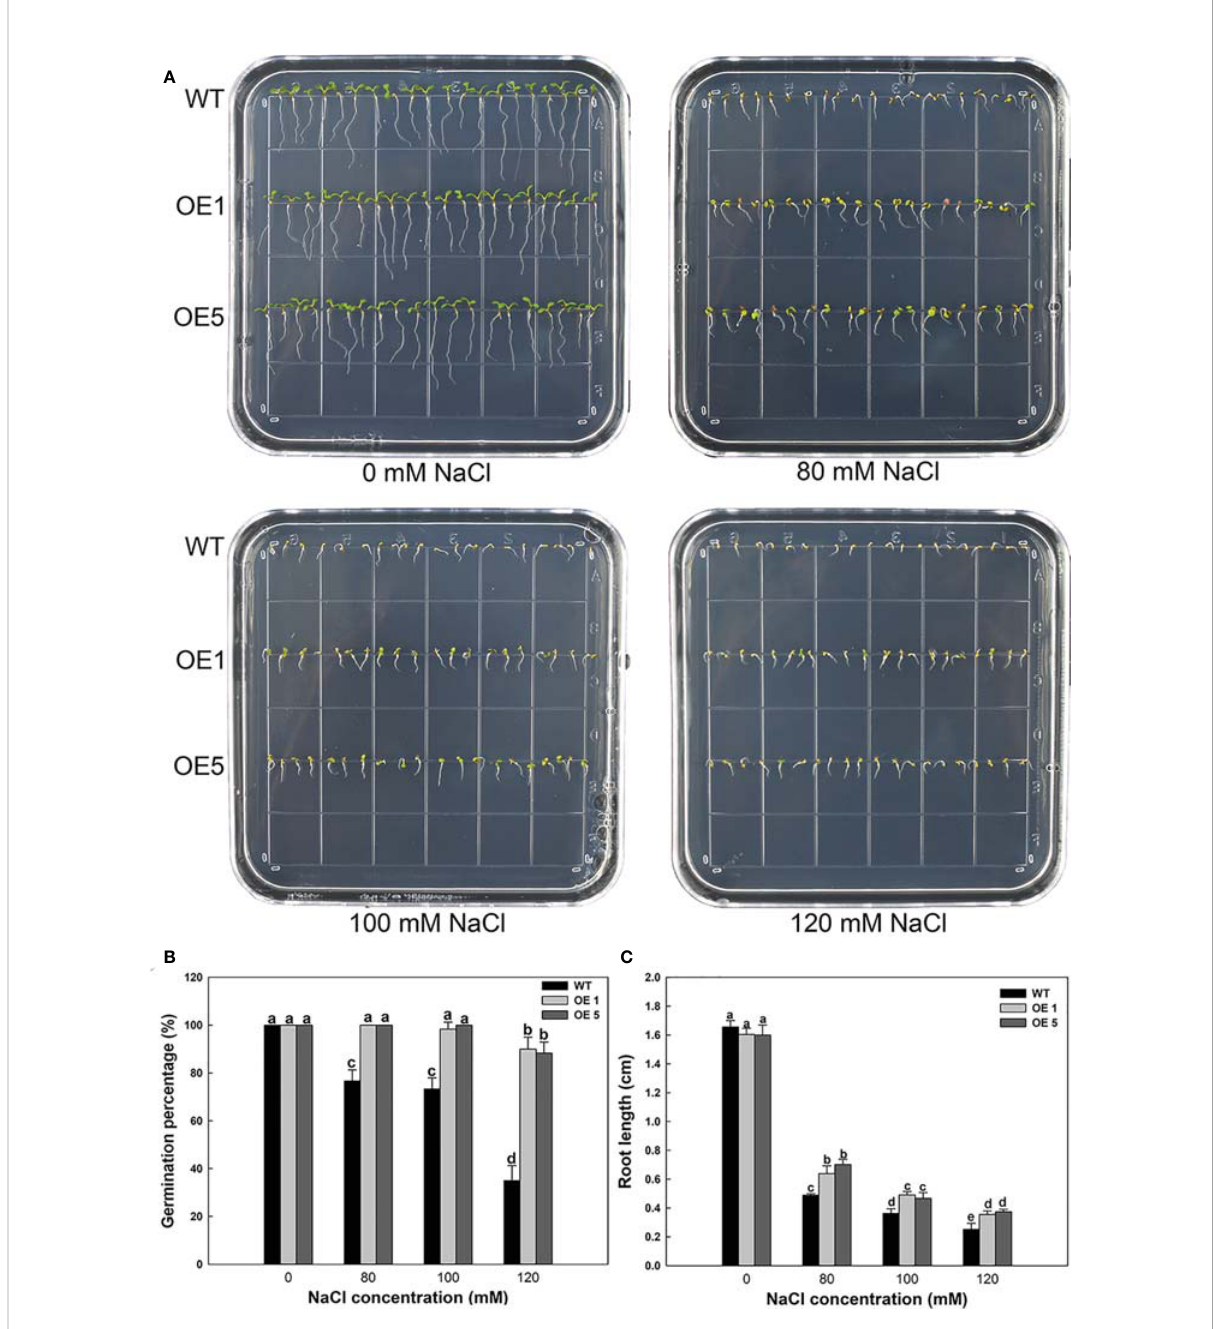
FIGURE 6 Heterologous expression of LbMYB48 enhances salt tolerance at the seedling stage in transgenic A. thaliana . (A) Phenotype of LbMYB48 over- expression lines versus wild-type lines grown for 5 d under different NaCl concentrations; (B) 24 h germination percentage of the wild-type and two over-expression lines treated with different concentrations of NaCl; (C) Root length of wild-type A. thaliana and two over-expression lines grown for 5 d under different salt concentrations. This experiment had three replicates to calculate the standard deviation (SD). Different letters (a – g) were used to indicate signi fi cant differences between different columns at P <